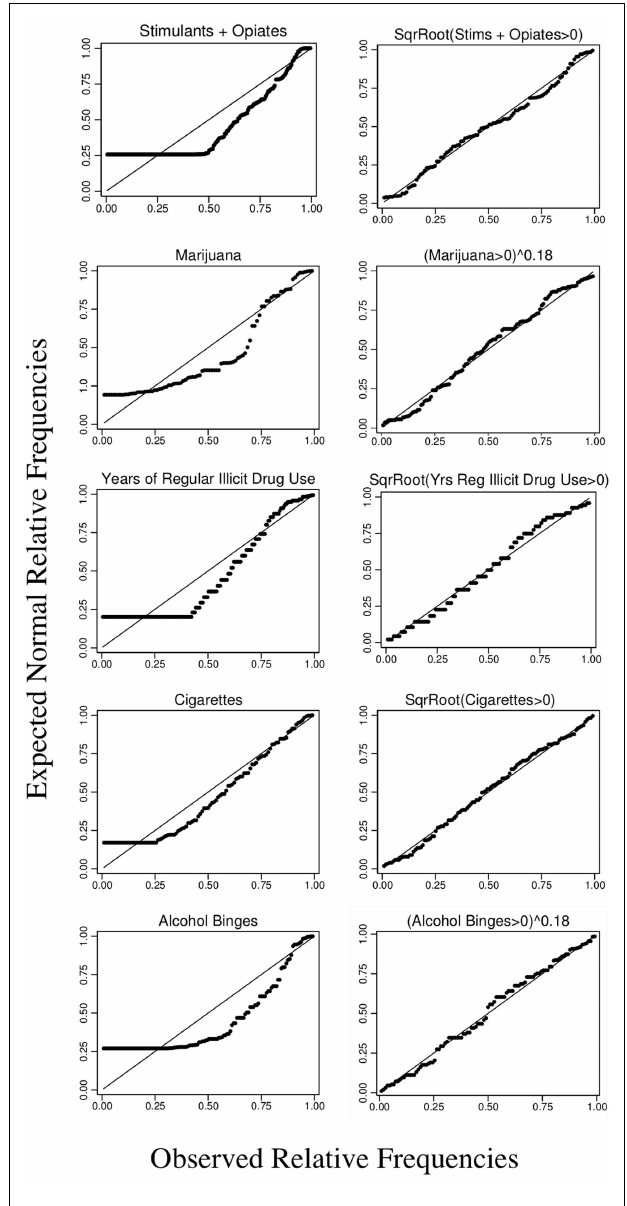
FIGURE 1 | Normal probability graphs of frequency of drug use and years of regular illicit drug use ( > 2/week for a year or more) .The diagonal line plots a perfect correlation between the observed relative frequencies of use and the predicted relative frequencies assuming a normal distribution.The left panels show the untransformed frequencies including subjects who reported no use.The right panels show the transformed frequencies (square root or power with an exponent of 0.18) for subjects who used one or more